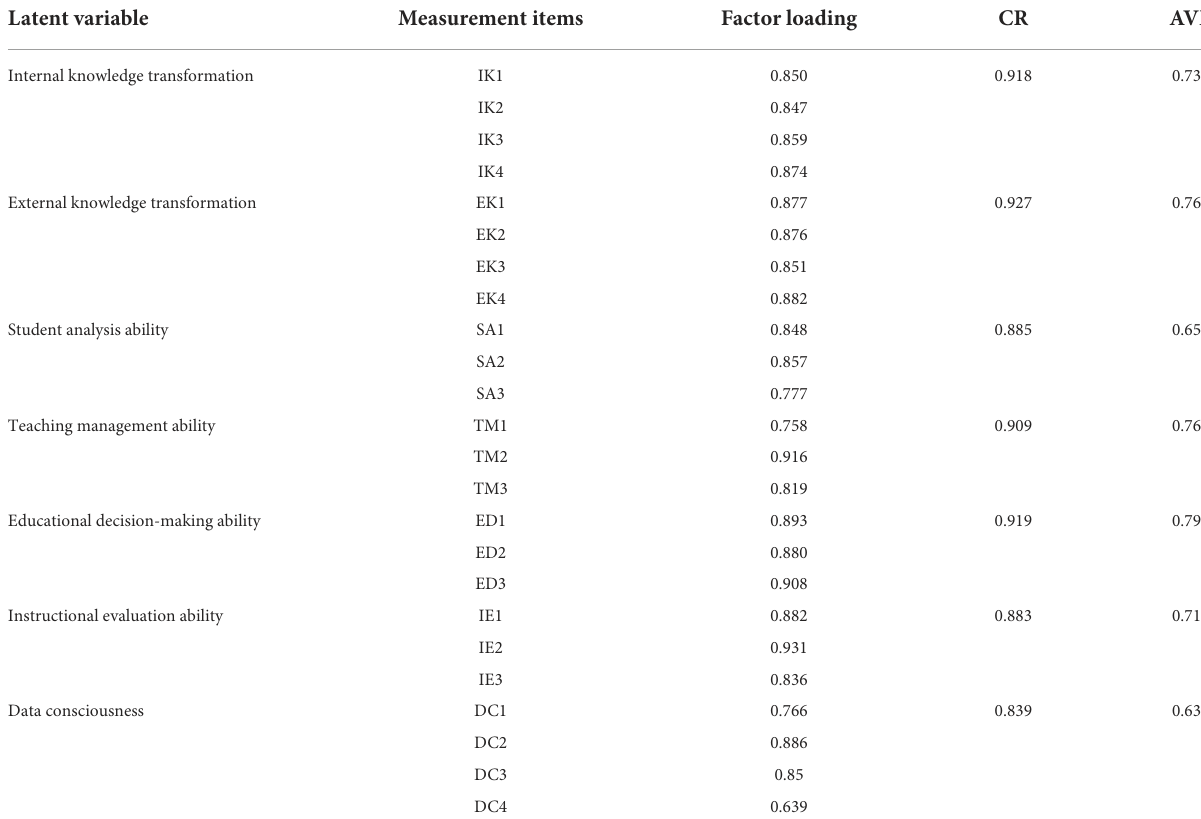
TABLE 4 Results of confirmatory factor analysis.